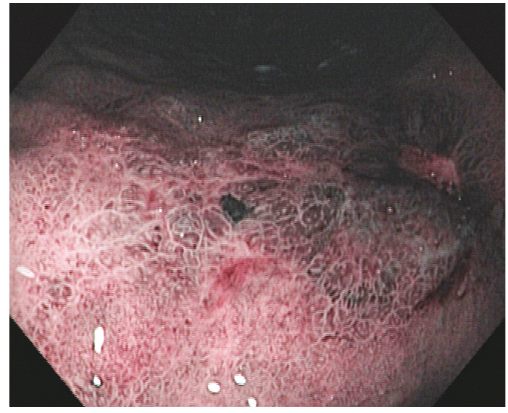
Figure 3: Large ulcer examined with narrow band imaging. NBI visualizes irregular surface architecture and disturbed vascular structures. Histopathology confirmed diagnosis of